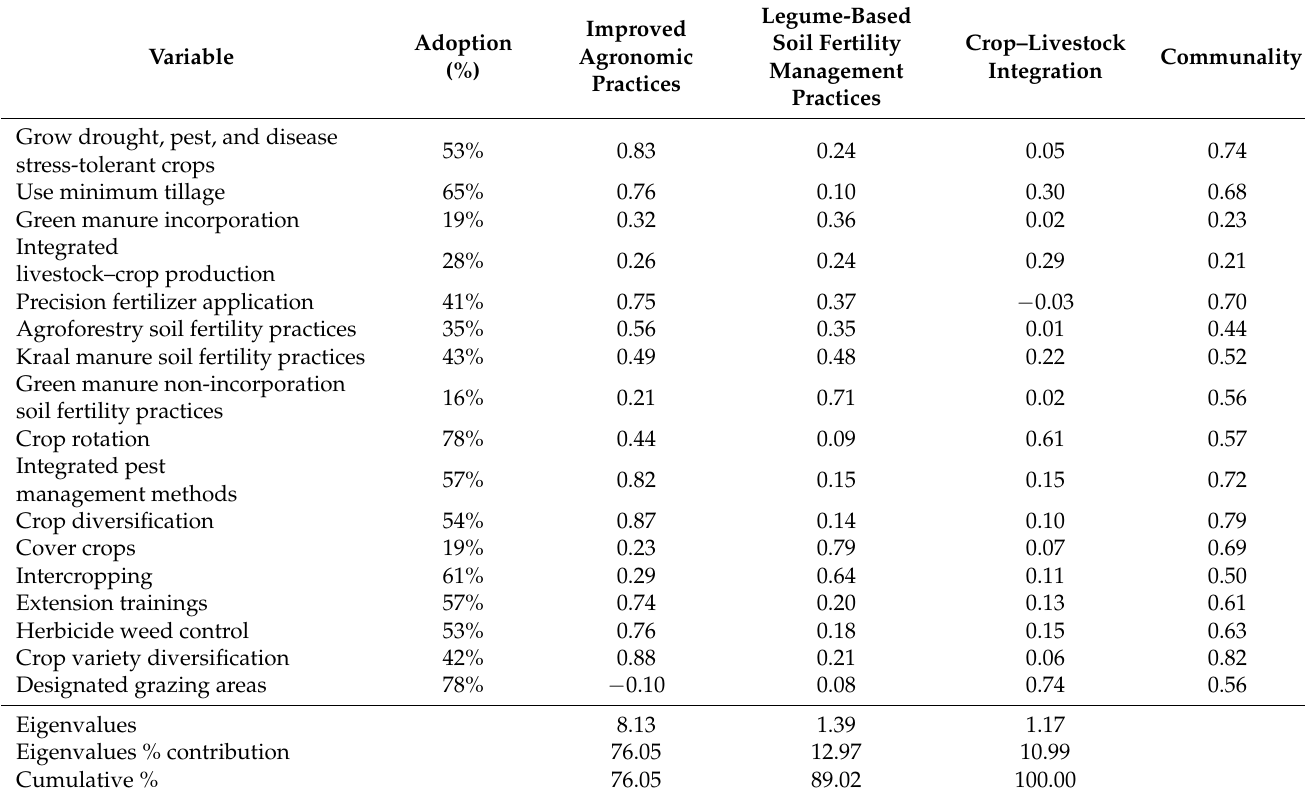
Table 2. Classification of SAI practices based on Principal Components